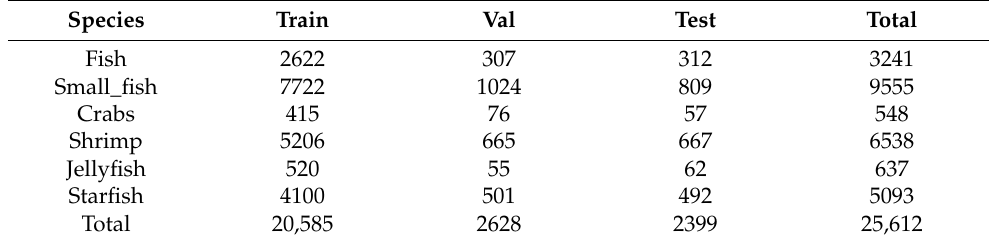
Table 1. The details of partitioning the